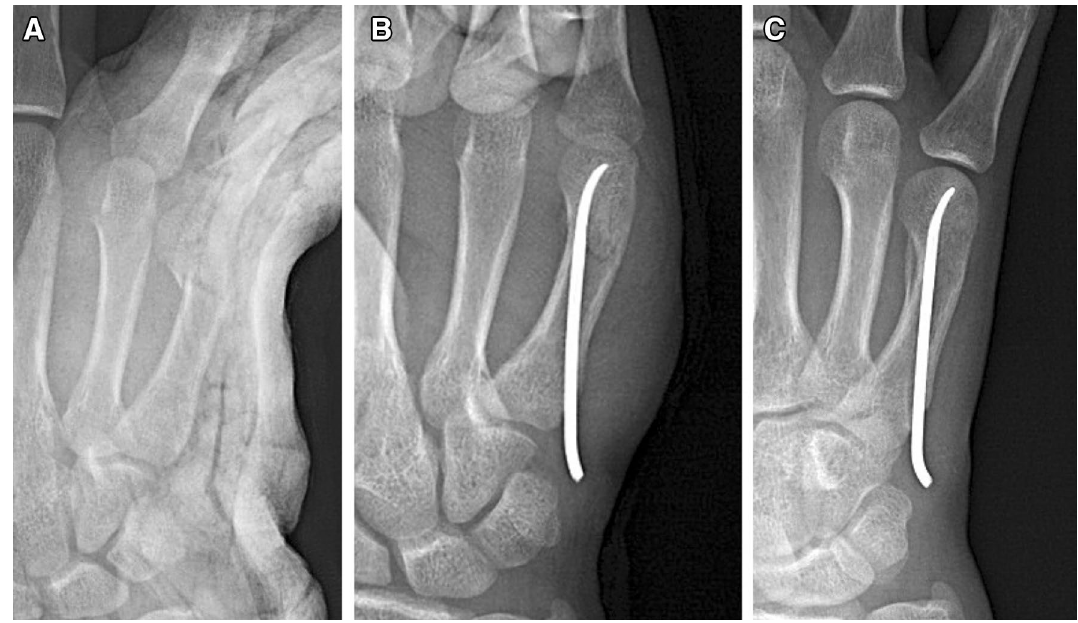
Figure 2. Clinical case of an FMNF treated by single AEIMN. Preoperative oblique view radiograph ( A ). Postoperative radiographs showing a good reduction of the fracture ( B ) . Radiograph at 8 weeks after the operation shows union of the fracture ( C